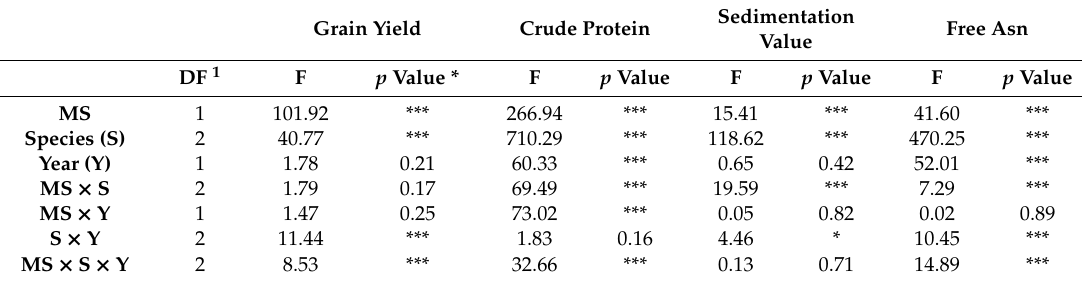
Table 5. F-values and p -values for main e ff ects: management system (MS), species, year and interactions between factors on grain yield, crude protein content, sedimentation value and the Asn content of the